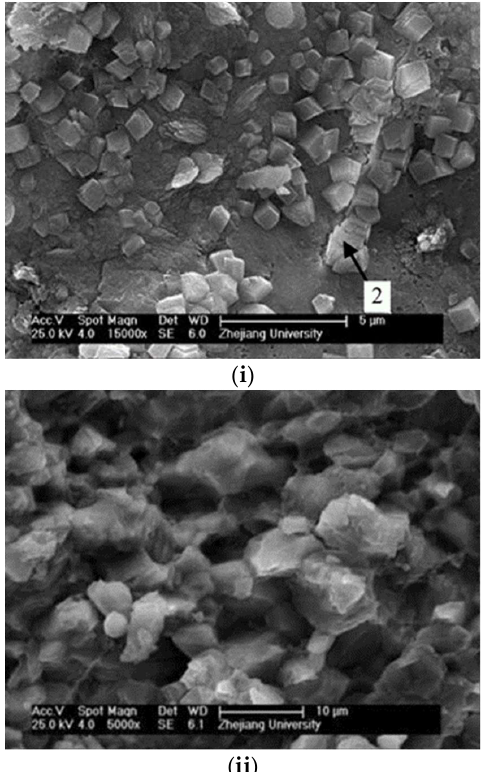
Figure 22. SEM image ( i ) in pore and ( ii ) on the surface [44]. Reproduced with permission from [44], Elsevier, 2010. Through the triple-mixing approach, the loose surface of RCA was densified by in- corporating the mineral admixtures: finely ground slag and fly ash. Both admixtures showed evident results in filling the voids and forming new hydration products by consumption of CH. Figure 23 shows active densification of the surface, which strengthened the recycled aggregates.